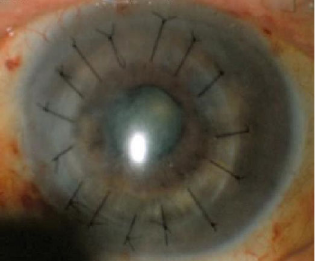
Figure 3: Slit-lamp microscopy image of the patient ’ s left eye, taken on the day after his operation. The corneal graft was clear, and the depth of the anterior chamber was nearly